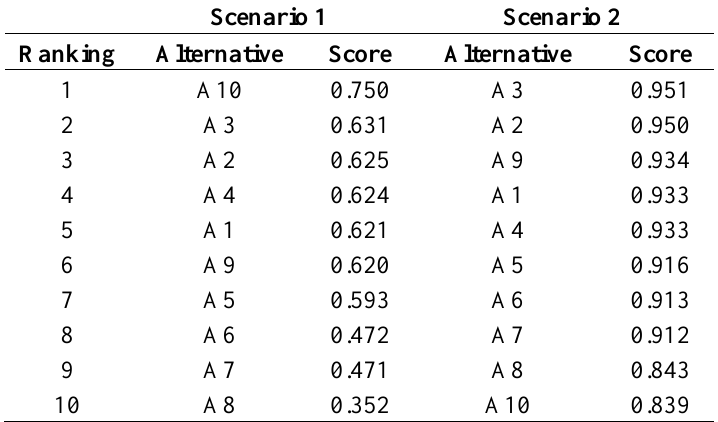
Table 7. The performance score and the ranking order of each alternative for the two scenarios.